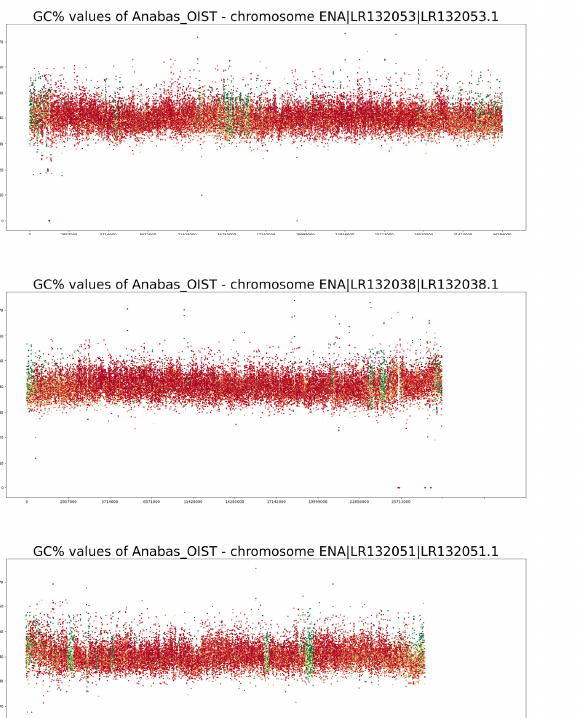
Figure A1. GC% and rep% profiles in chromosomes in Cottoperca gobio soft-masked in this study.